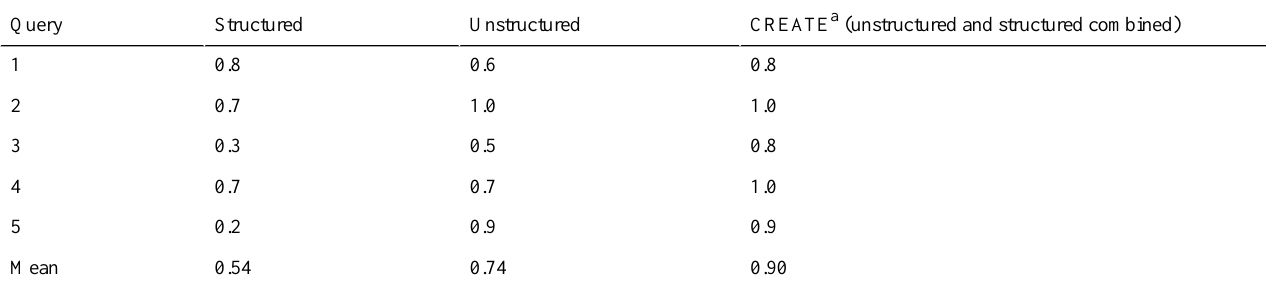
Table 3. Precision at 5 of sampled queries for electronic health record